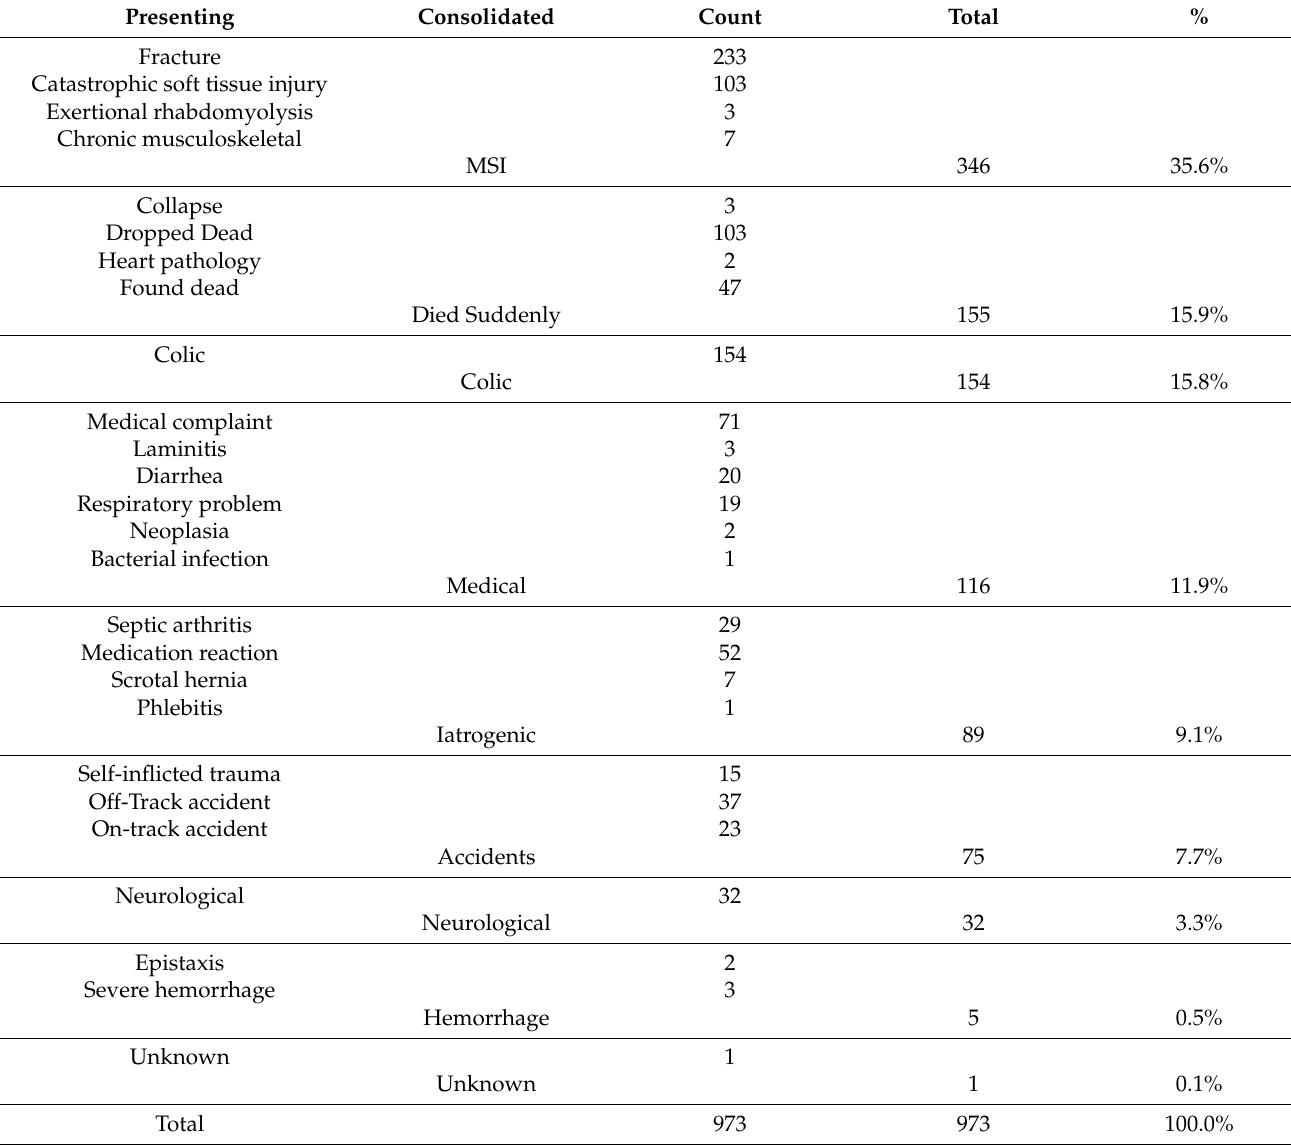
Table 1. Presenting and consolidated complaints for standardbred cases in the Ontario Racing Death Registry from 2003–2015. MSI: musculoskeletal injuries.